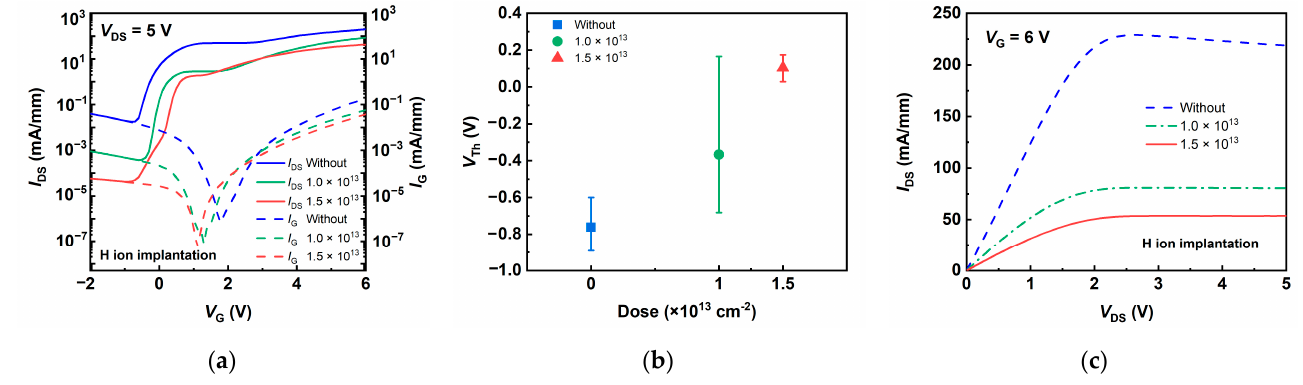
Figure 3. ( a ) Transfer characteristics in log scale; ( b ) average values and errors of threshold voltages; ( c ) output characteristics at V G = 6 V of p-GaN HEMTs without H ion implantation and with H ion implantation doses of 1.0 × 10 13 cm − 2 and 1.5 × 10 13 cm − 2 , without annealing.